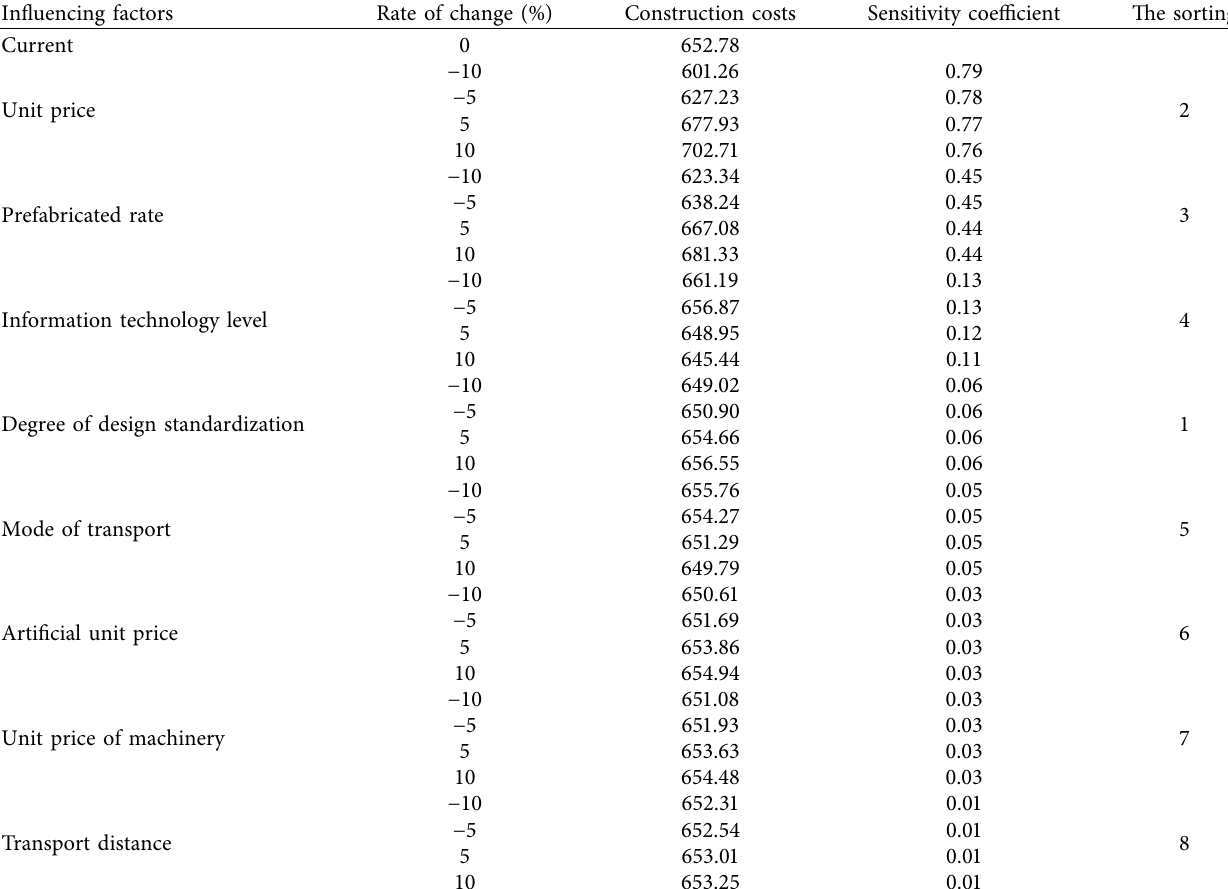
Table 5: Sensitivity analysis table.